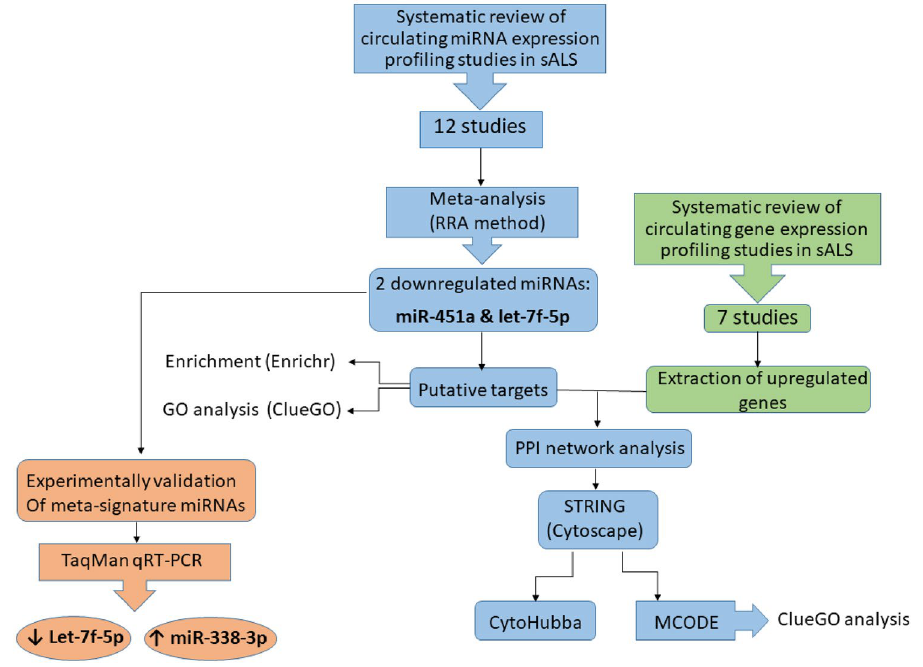
Figure 1. Overview of the study